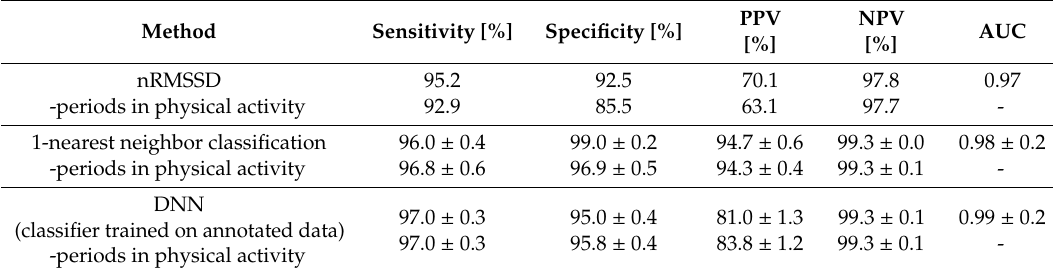
Table 2. Mean interpretable time, sensitivity, specificity, positive predictive value, negative predictive value, and AUC of ROC-analysis for detection of AF by using PPG analysis overall and during moderate physical activity and the average sensitivity / specificity with SD estimated with 1-nearest neighbor classification and a deep neural network trained on five-minute periods on di ff erent training and validation test splits.